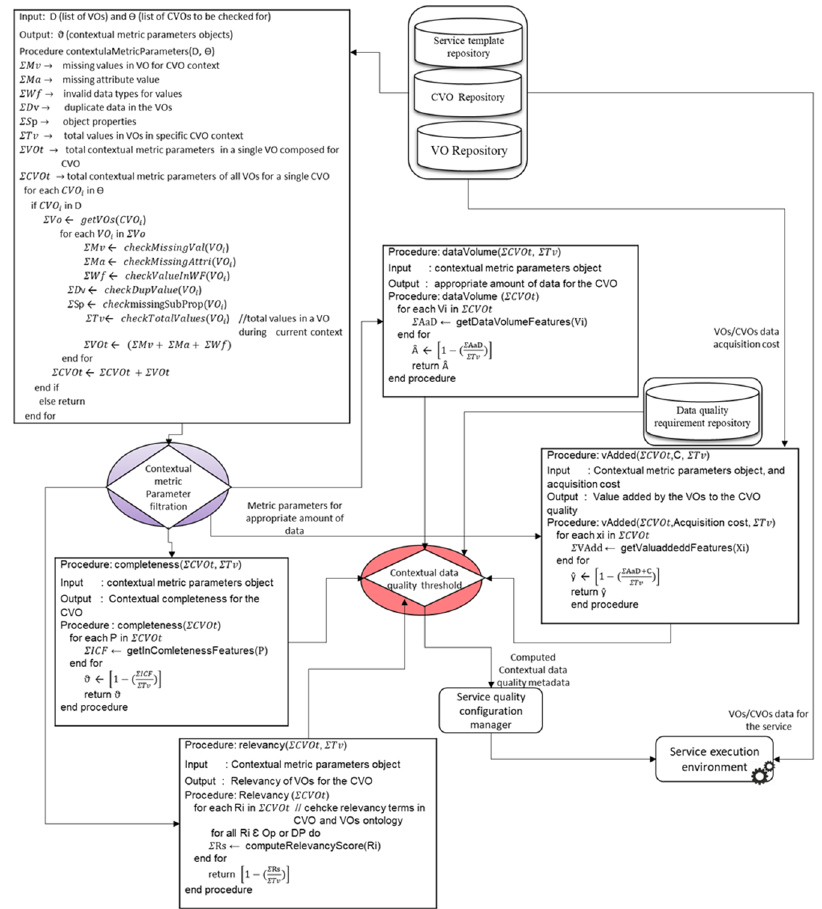
Figure 14. Flow diagram to obtain the features for contextual data quality assessment.